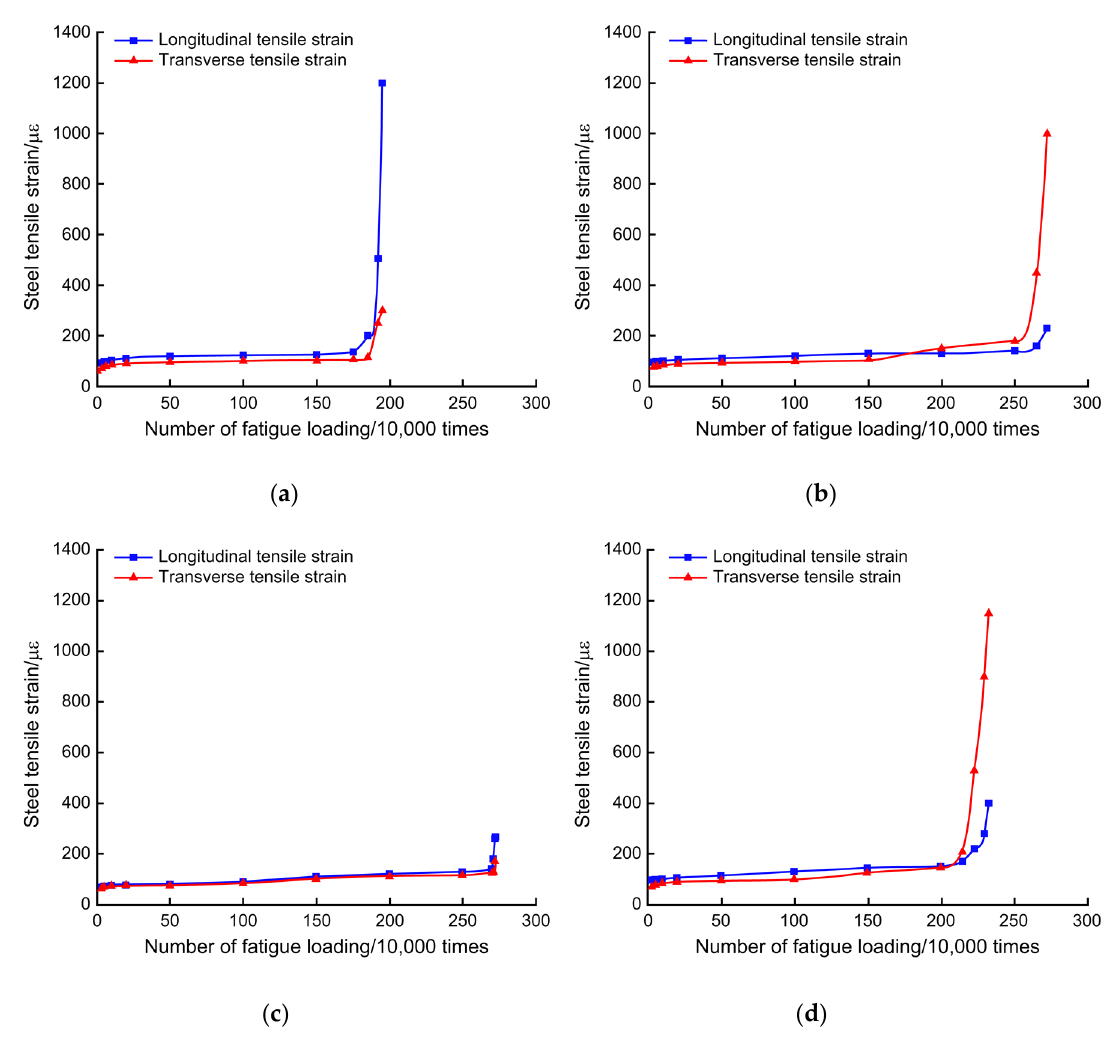
Figure 14. Change in steel tensile strain under the slab based on number of fatigue loading cycles ( a ) PL2, ( b ) PL3, ( c ) PL4, and ( d ) PL5.